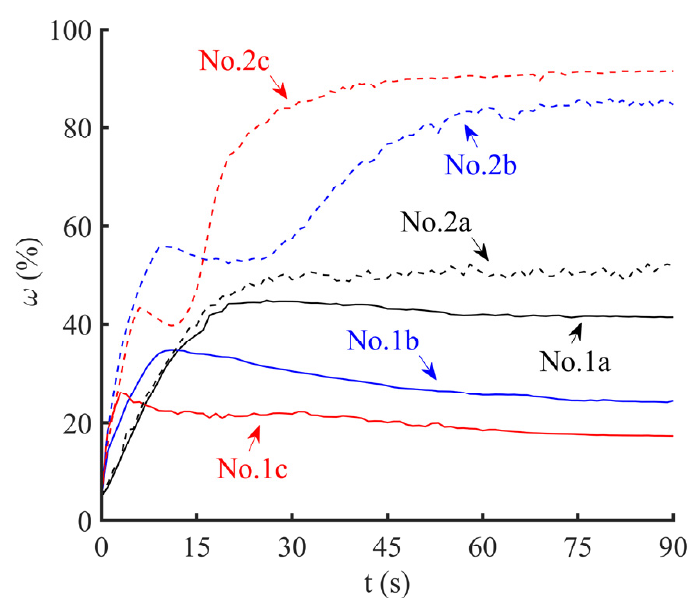
Figure 5. Development of 𝜔